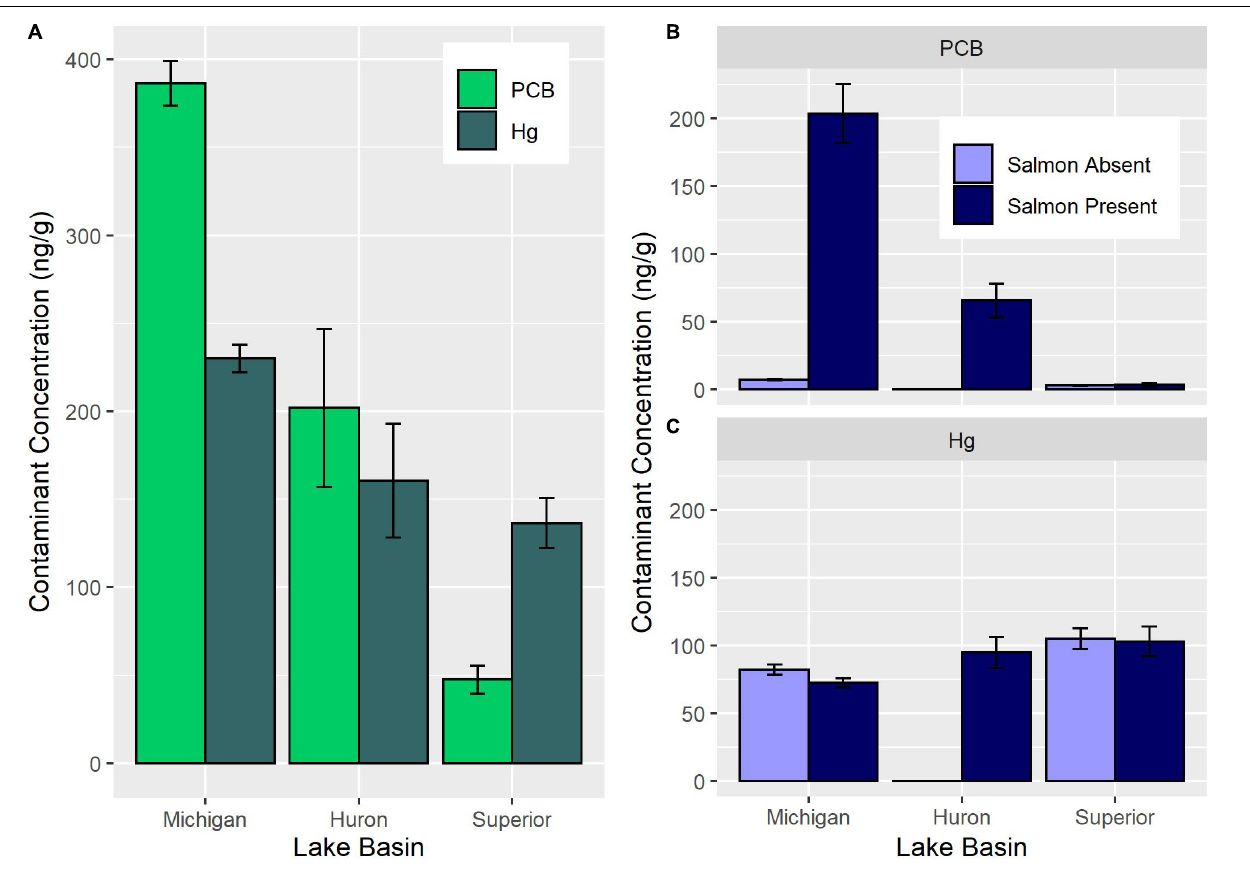
FIGURE 2 | Spawning Pacific salmon exhibit basin-specific differences in PCB and Hg concentrations across Lakes Michigan, Huron, and Superior (A) . Stream-resident fish exhibit PCB concentrations that differ among lake basins and between locations open to Pacific salmon (B) . Stream-resident fish exhibit Hg concentrations that differ among lake basins but not with the presence of Pacific salmon (C) . Note the magnitude of difference is much more pronounced for PCB than Hg. No stream-resident fish were collected from salmon absent Lake Huron tributaries. All concentrations expressed as ng/g wet weight. Data source: Gerig,